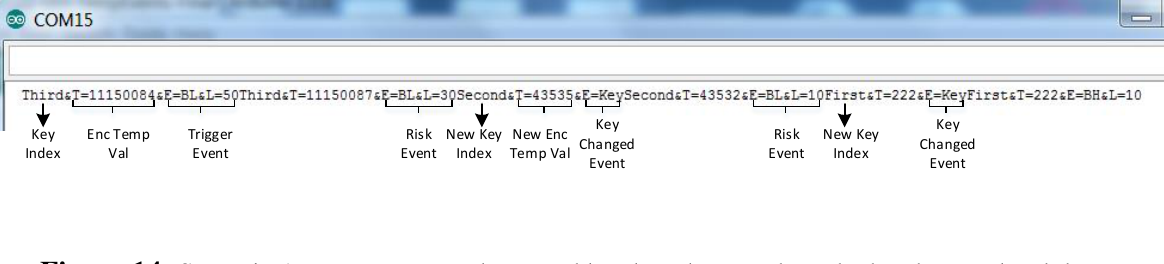
Figure 14. Scenario 1: sensor screen: decreased key lengths are adapted when battery level drops.